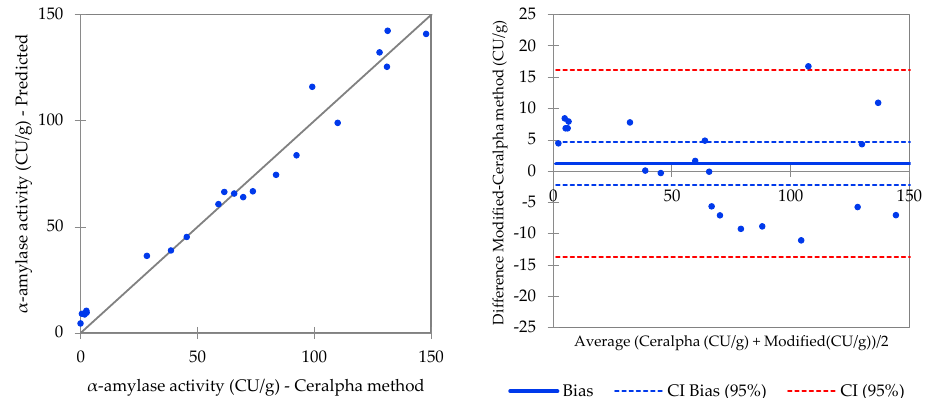
Figure 4. The Bland-Altman analysis of the agreement between the Ceralpha method and the proposed modified FN method using 0.1 g of malt flour (Nonlinear estimation of FN).